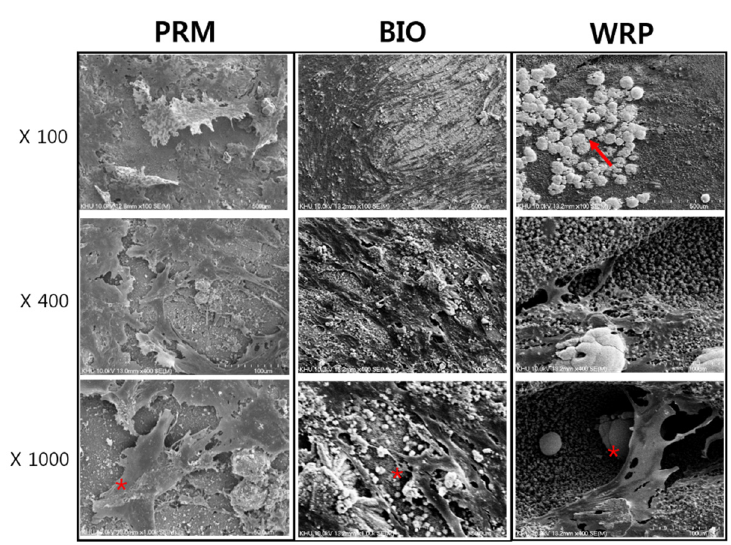
Figure 3. Scanning electron microscopic images of the DPSCs that were on the surface of different MTA materials. MTA